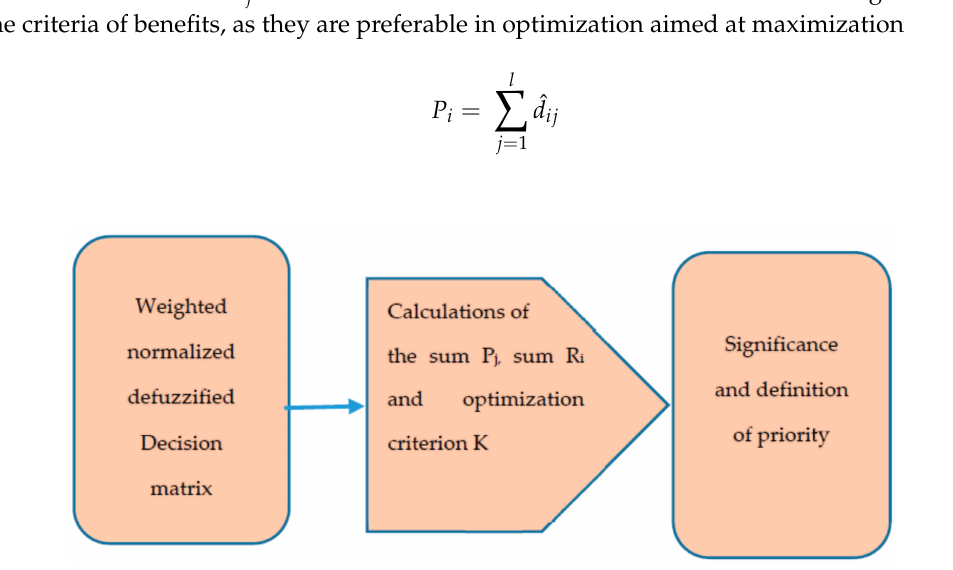
Figure 9. Significance and definition of